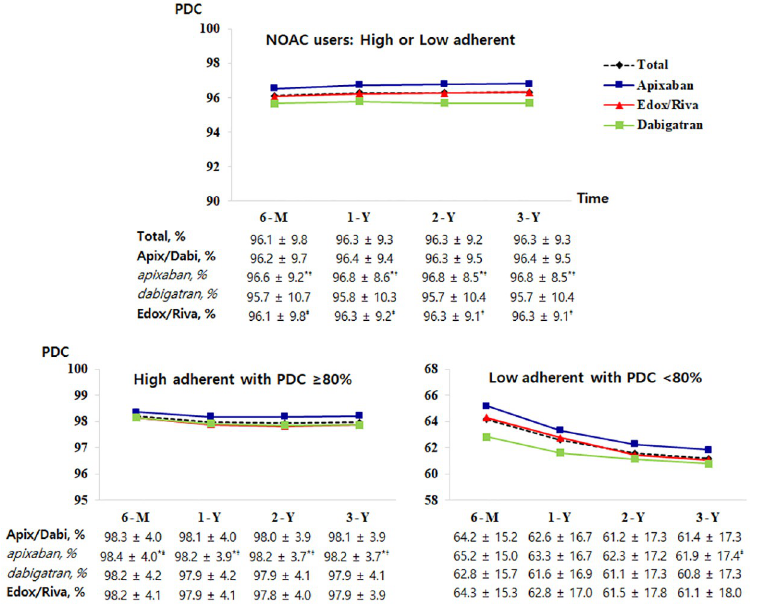
Fig 3. Time-specific PDC for each NOAC. PDC, proportion of days covered; NOAC, non-vitamin K antagonist oral anticoagulant; M, month; Y, year; Apix/Dabi, apixaban or dabigatran; Edox/Riva, edoxaban or rivaroxaban; * p value < 0.001 compared with Edox/Riva users; † p value < 0.001 compared with dabigatran users; ‡ p value < 0.01 compared with dabigatran users.